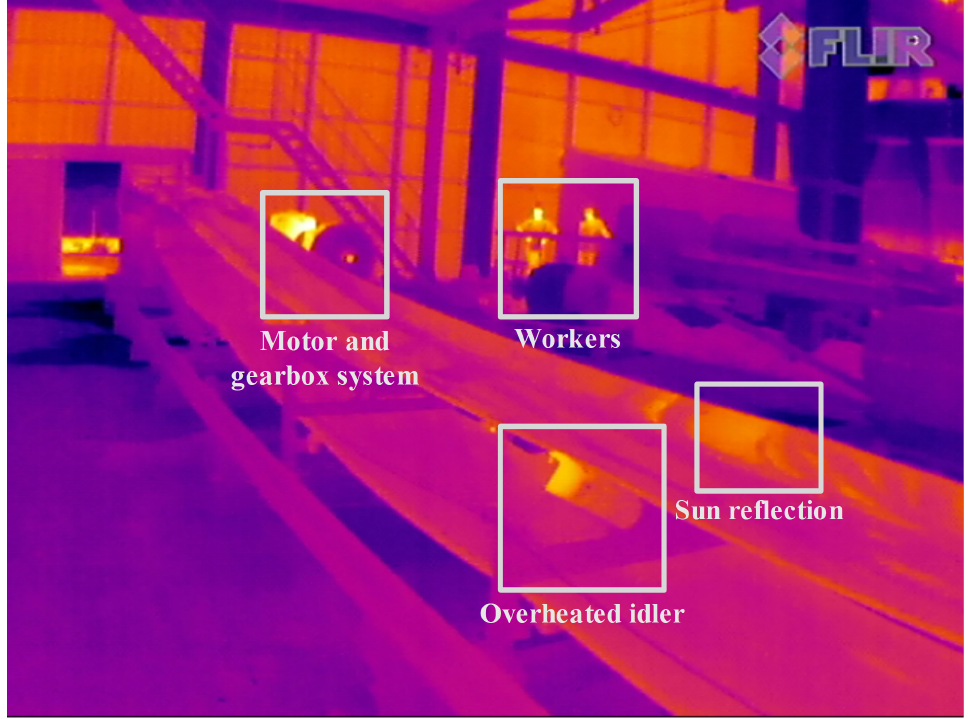
Figure 6. Examples of IR sources that are not related to